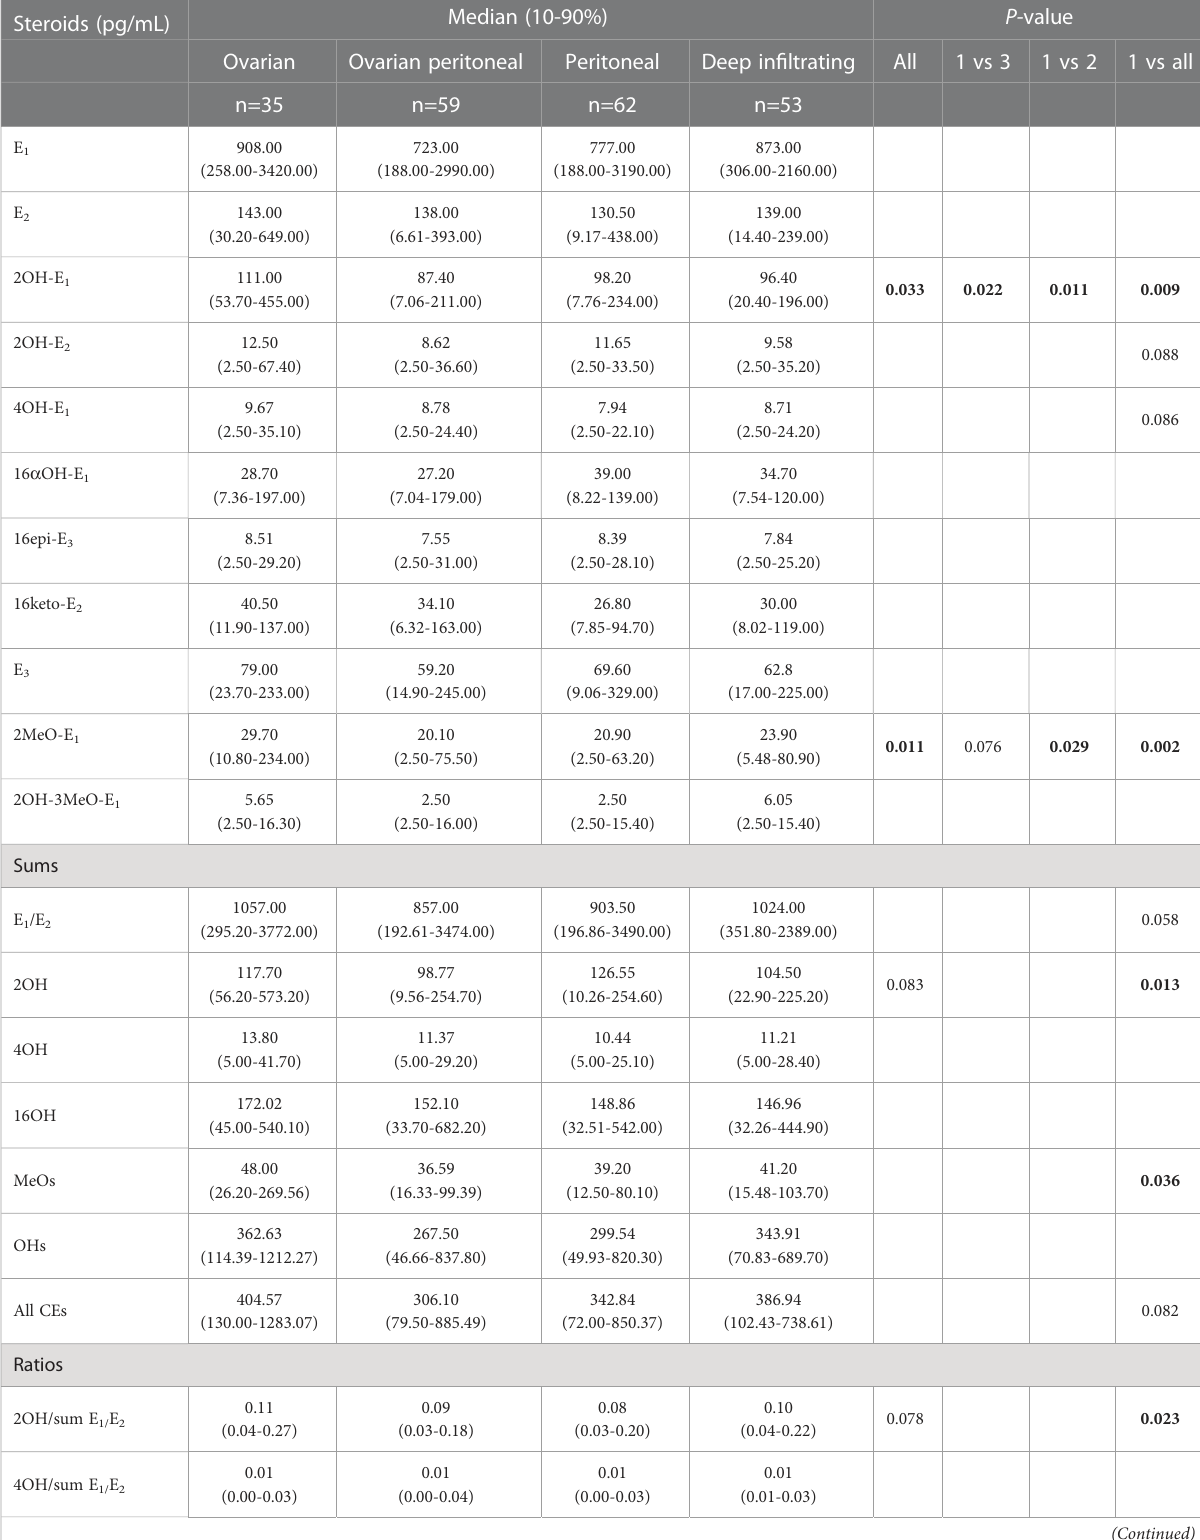
TABLE 3 Steroid levels according to anatomic sites of disease in 209 endometriosis